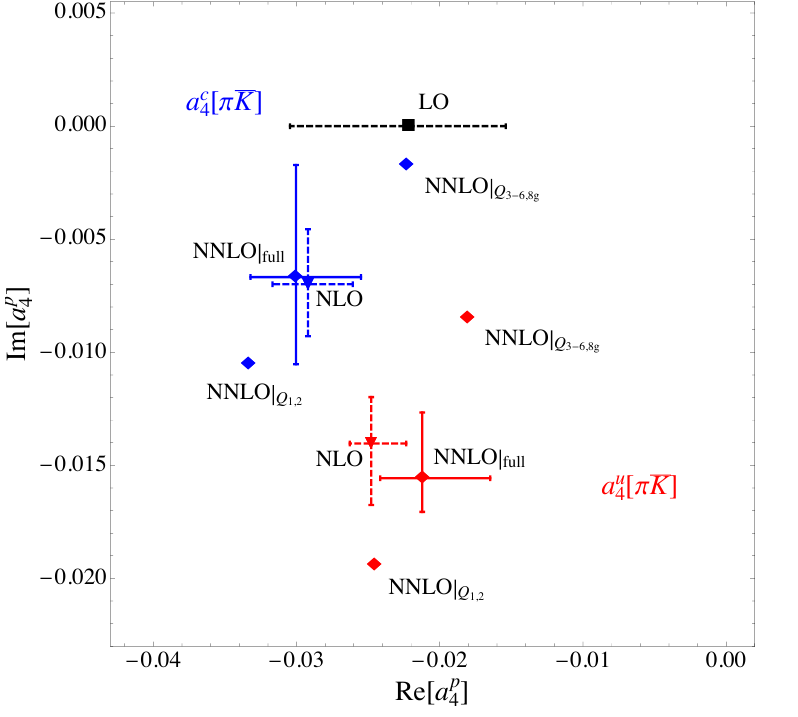
Figure 8 . Anatomy of QCD corrections to a u refer to a u , those to the upper left (blue in colour) to a c 4 for further